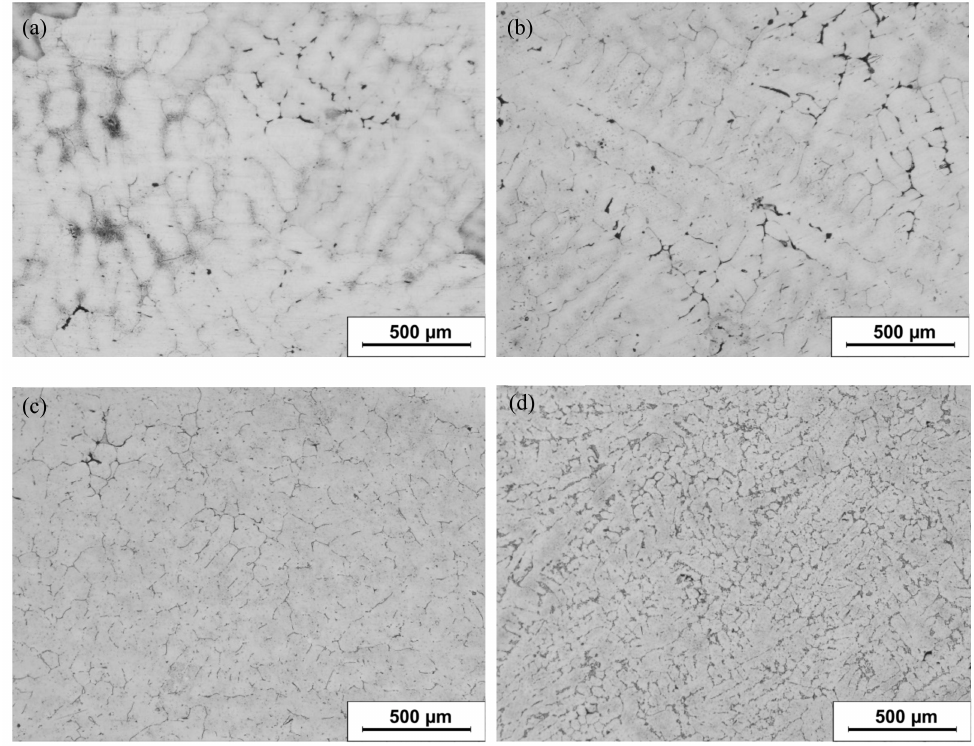
Figure 1. Optical microstructure of Al–5Zn–0.03In– x Er alloys: ( a ) Al–5Zn–0.03In; ( b ) Al–5Zn–0.03In– 0.5Er; ( c ) Al–5Zn–0.03In–1Er; ( d )